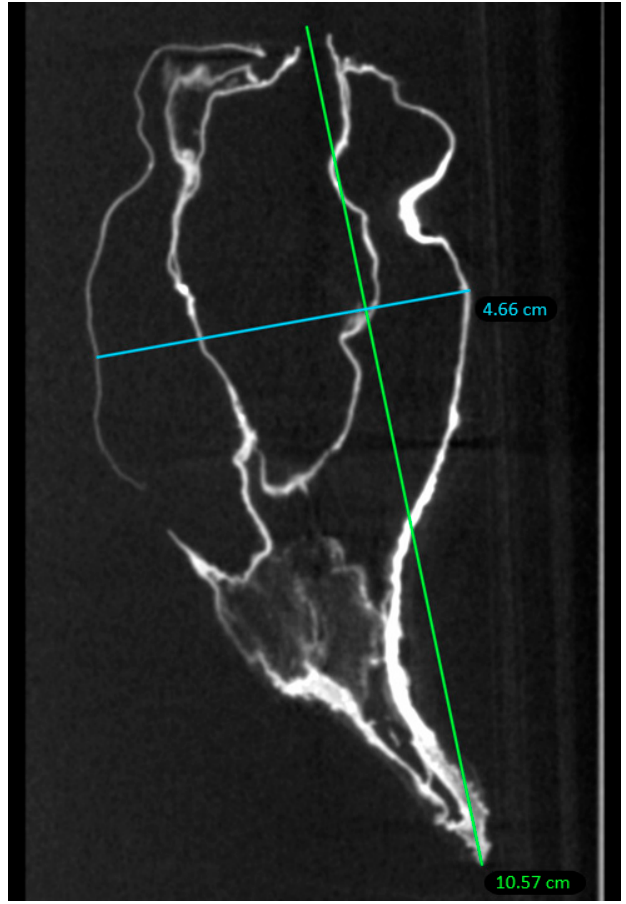
Figure 3. Axial measurements of the heart of P. Jaricot .